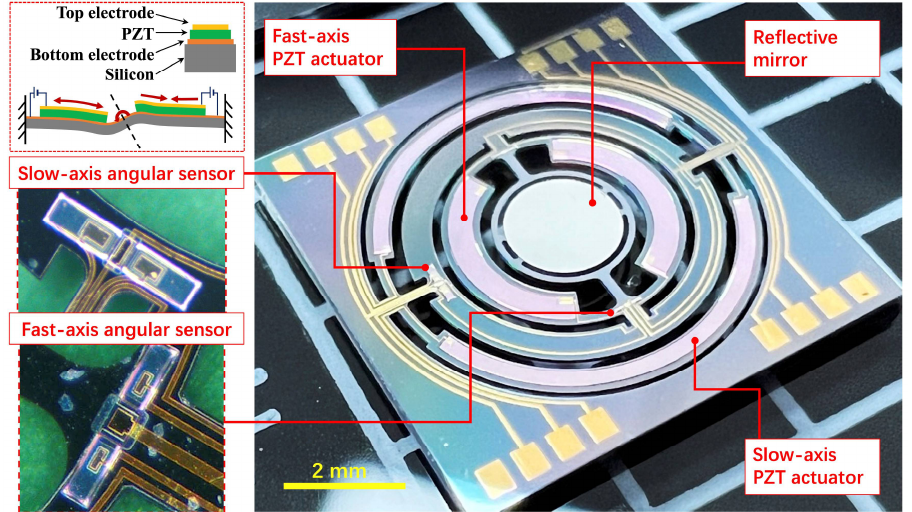
Figure 3. The structure of piezoelectric MEMS mirror with built-in PZT actuator and angular feed- back sensor for bi-axial Lissajous scanning.